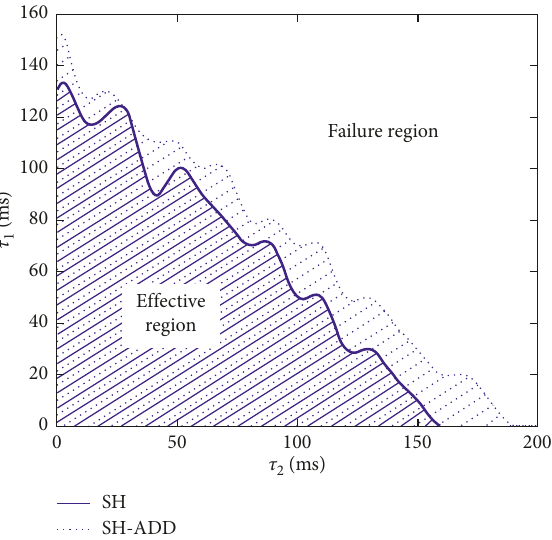
Figure 26: Time delay boundary curves of SH and SH-ADD controls when the velocity is 250km/h.